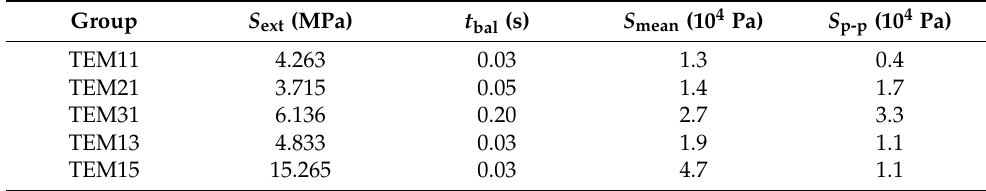
Figure 11. Axial compressive stress signals on the stress concentration node of the pressboard in phase 3 under different vibration conditions (a) TEM11,(b) TEM21,(c) TEM31,(d) TEM13,(e) TEM15. Table 4. Time domain characteristic parameters of axial compressive stress on the stress concentration node of the pressboard under different vibration conditions.